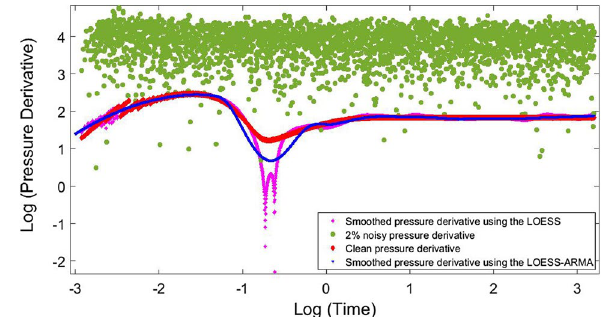
Fig. 11 MSE for hard and soft iterative thresholding at different itera- tion